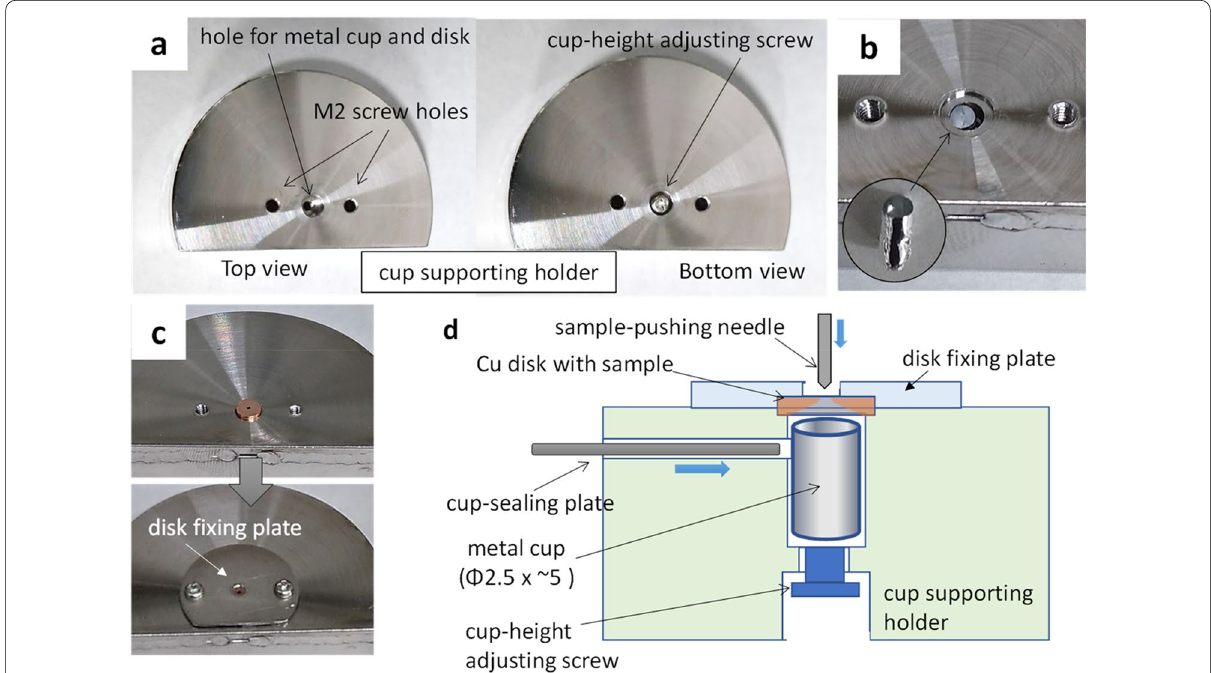
Fig. 10 Photographs and a schematic diagram of the sample encapsulation tool. a . The cup supporting holder had a hole for the metal cup and Cu disk. The height of the cup can be adjusted with a cup-height adjusting screw. b . A metal cup of < 3 mm diameter can be installed. c . A Cu disk with a pelletized sample was set and fastened with the cup supporting holder using the disk fixing plate. d . The pelletized sample was dropped off from the Cu disk by pushing it forward with the sample-pushing needle (made of stainless-steel), and then the metal cup was closed by pressing it with the cup-sealing